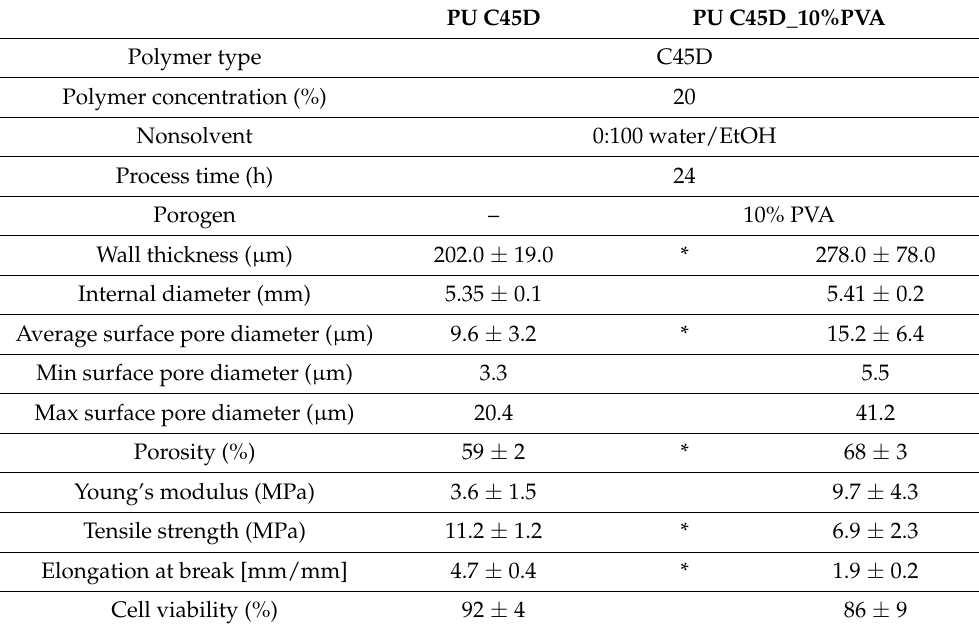
Table 6. Comparison of basic physical and mechanical parameters of scaffolds obtained for selected process parameters ( n =